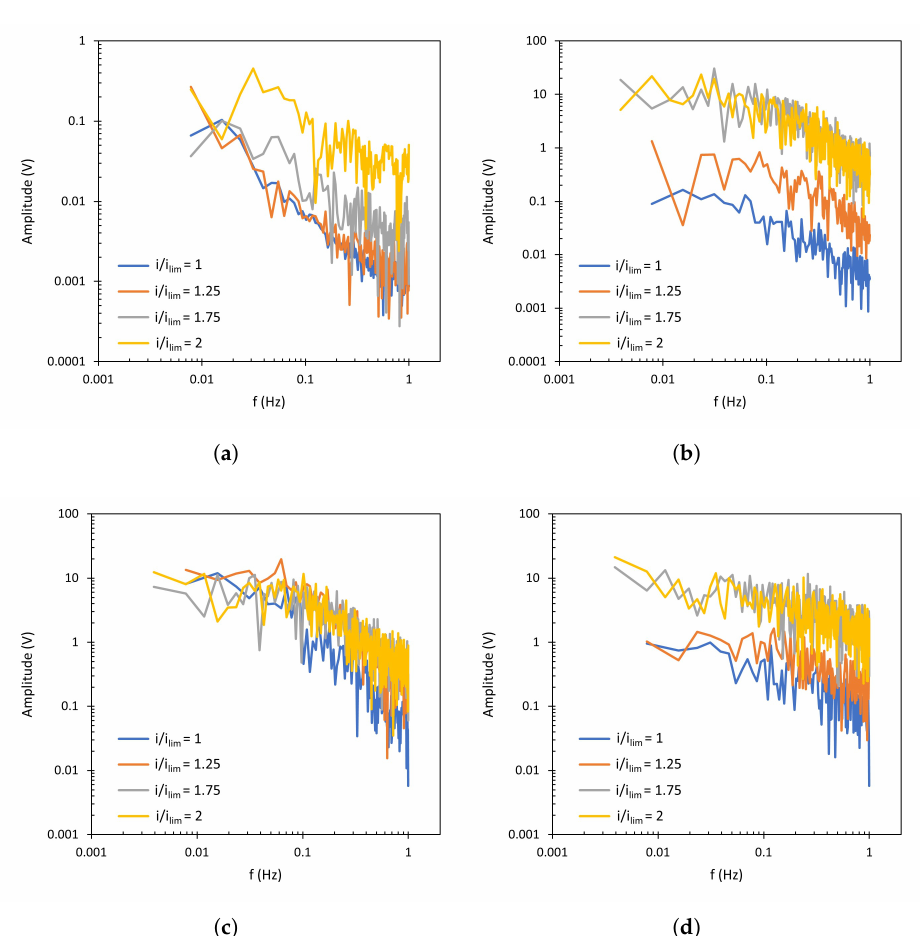
Figure 8. Fourier Transform of the membrane HC-A at ( a ) 0 rpm, ( b ) 200 rpm, ( c ) 400 rpm, ( d ) 600